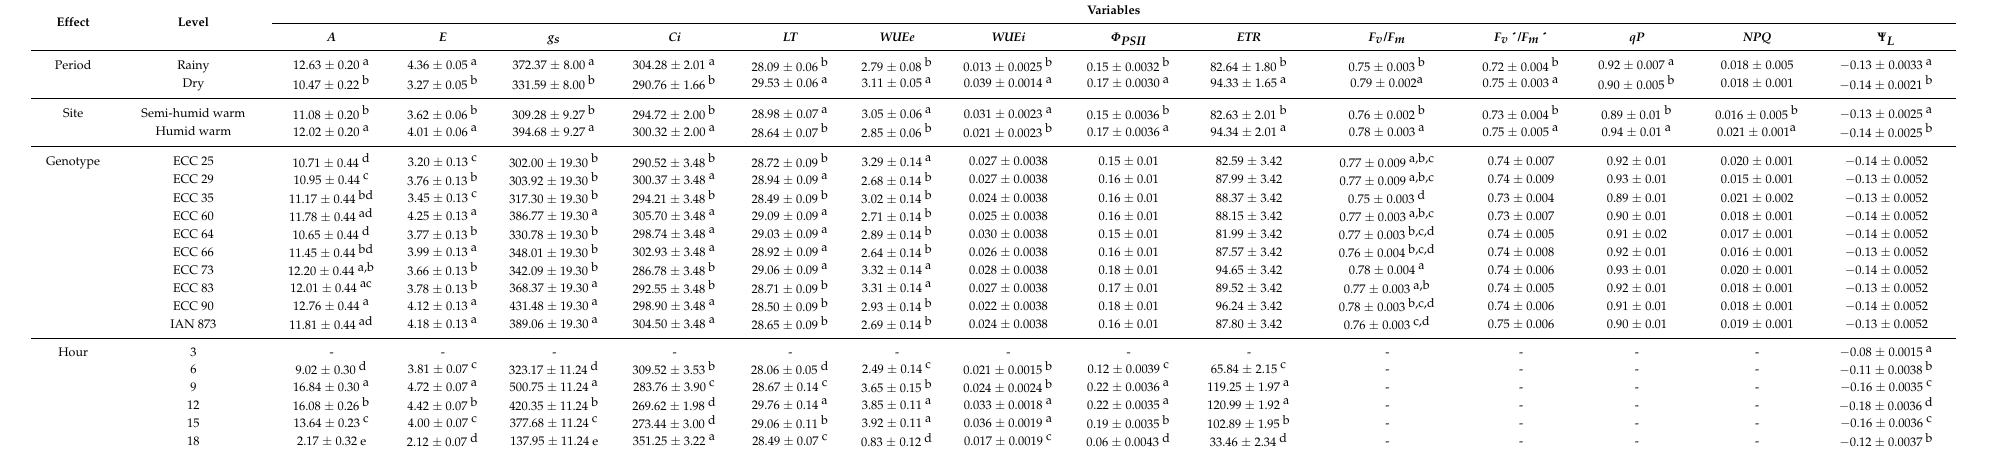
Table 3. Mean ± SE values for the net CO 2 assimilation rate ( A ) ( µ mol CO 2 m − 2 s − 1 ) at light saturation (1295 µ mol photons m − 2 s − 1 and 90 s illumination time), transpiration rate ( E